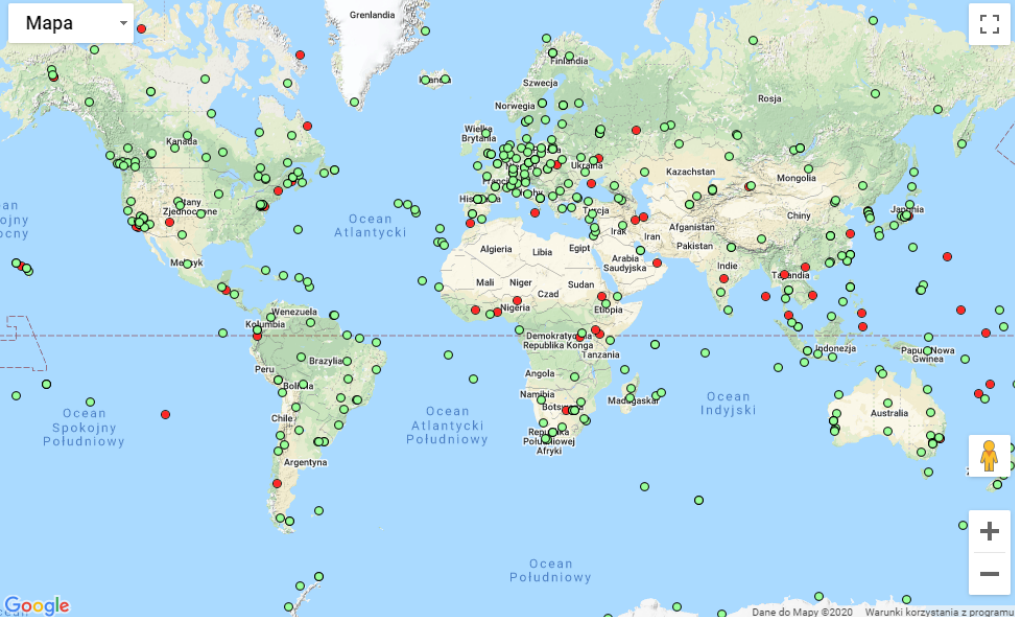
Figure 1. IGS’ permanent GNSS stations distribution (2 June 2020) as shown with Google Maps engine at http://www.igs.org/network with green dots marking currently available stations and red dots